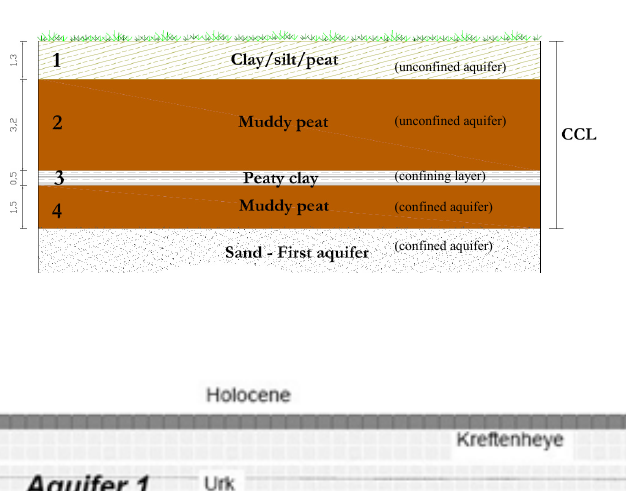
Fig. 8 Schematization of the CCL